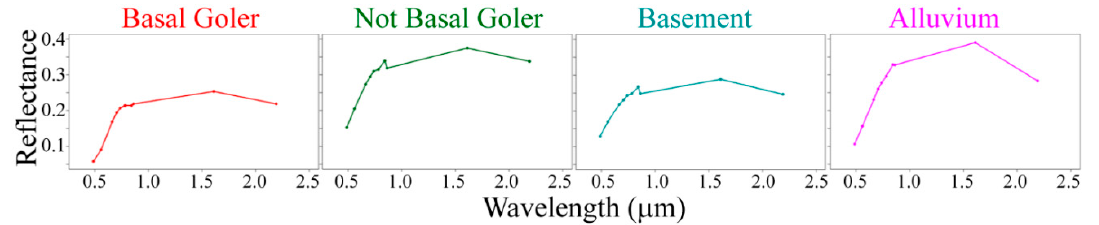
Figure 9. Goler multispectral endmembers. Spectral reflectance of geologic units near the Goler study as observed by Sentinel-2. Di ff erences in curvature and overall amplitude throughout the VSWIR spectral continuum result in at least four spectrally distinct geologic